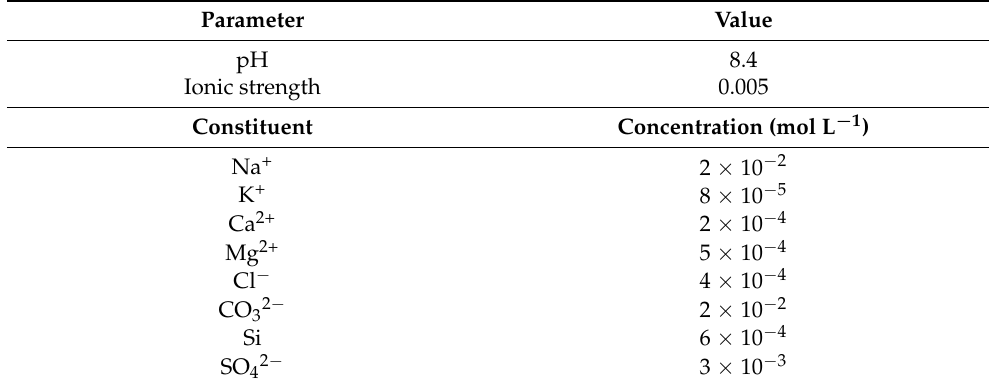
Table 2. Initial target solution chemistry of the Grimsel groundwater